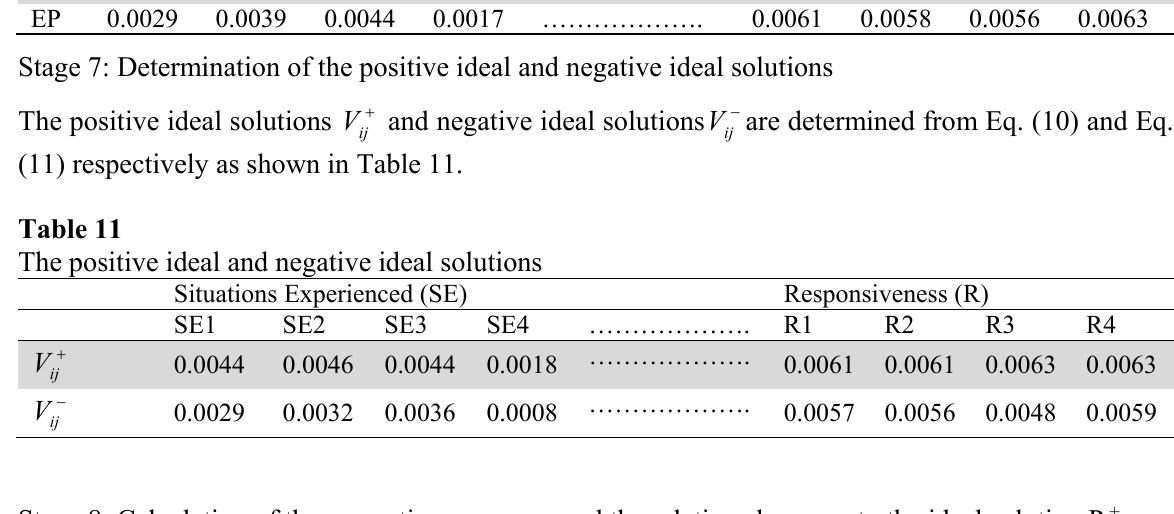
Stage 8: Calculation of the separation measures and the relative closeness to the ideal solution P i+ . The separation measures are calculated using the (cid:1865) -dimensional Euclidean distance. The separation measure calculated using Eq. (13). The relative closeness to the ideal